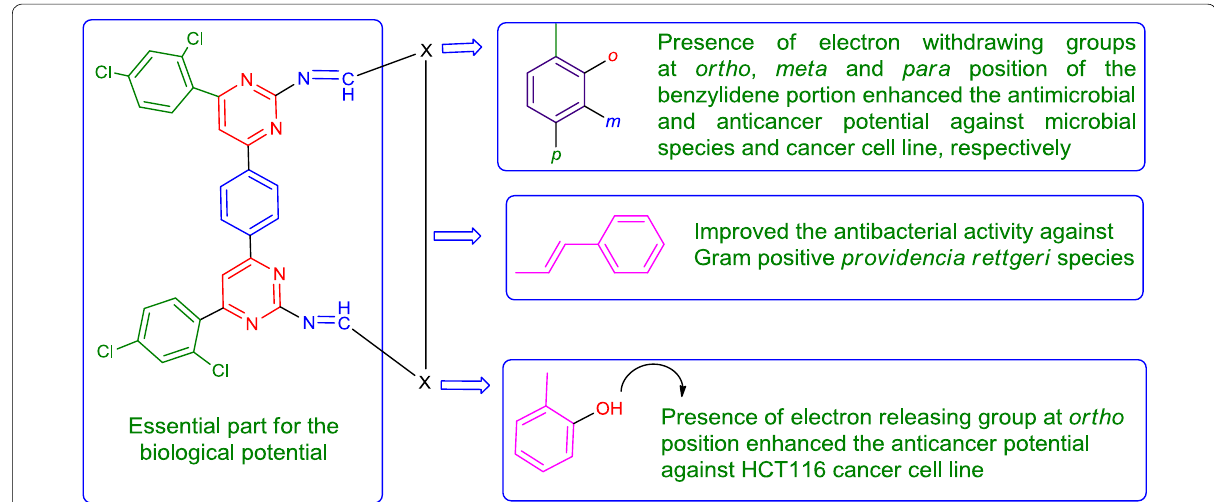
Fig. 4 Structural requirements for the antimicrobial and anticancer activities of synthesized bis-pyrimidine